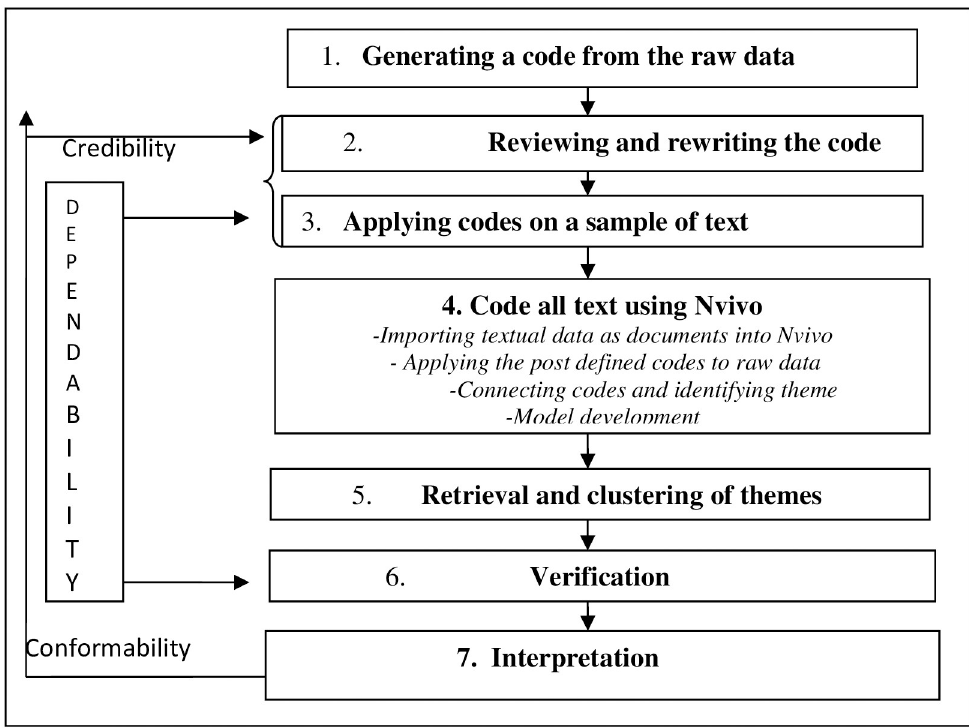
Fig 1. Data analysis process is about here. Source: Adapted from Eze et al., 2019.